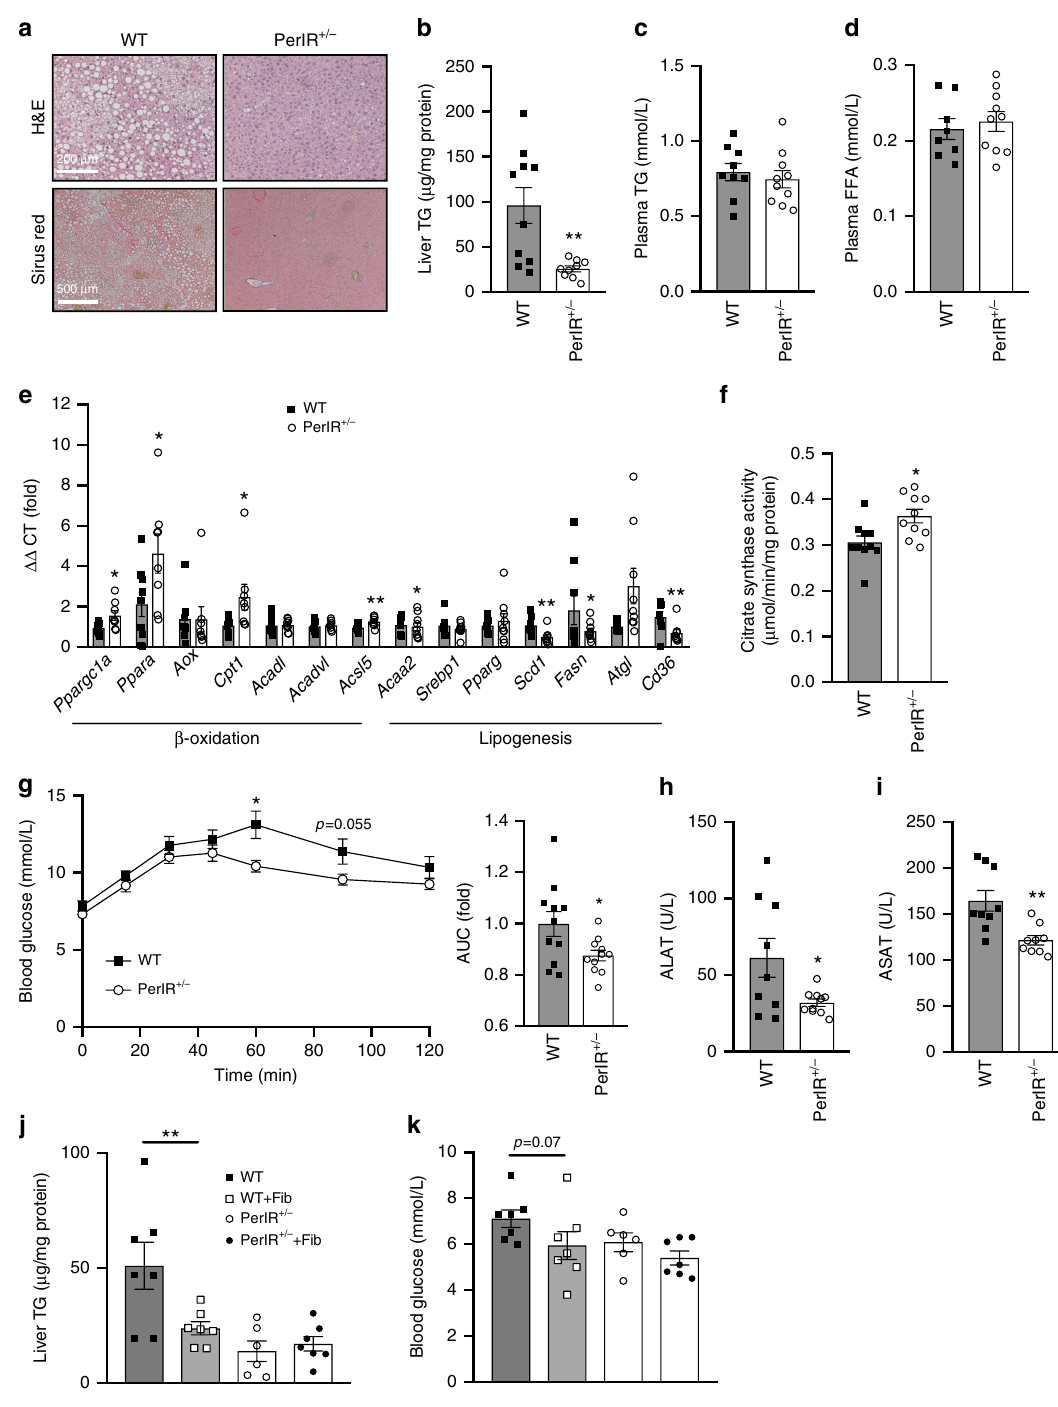
Fig. 4 The effect of partial peripheral tissue IR disruption on liver function in adult mice fed a high-fat diet. Livers from male WT and PerIRKO + / − mice fed a high-fat diet (HFD) for 10 weeks were processed for H&E, Sirius red staining, assayed for triglyceride content a , b , and plasma triglycerides (TG) and free fatty acids (FFA) were measured c , d . The expression of genes associated with lipid metabolism, and citrate synthase activity was determined e , f , a pyruvate tolerance test was performed g and plasma samples were analyzed for the liver damage enzymes ALAT, ASAT h , i . Ten days following tamoxifen (TX) treatment, male mice were fed a high-fat diet (HFD) for 10 weeks with or without the PPAR α agonist feno fi brate (Fib) and liver TG j and fasted blood glucose k was determined. Results are shown as means ± SE, with n ’ s represented as individual data point ’ s in fi gures. Signi fi cance was determined using two-tailed student ’ s t test or ANOVA with LSD post hoc analysis; * p < 0.05 and ** p < 0.01 vs